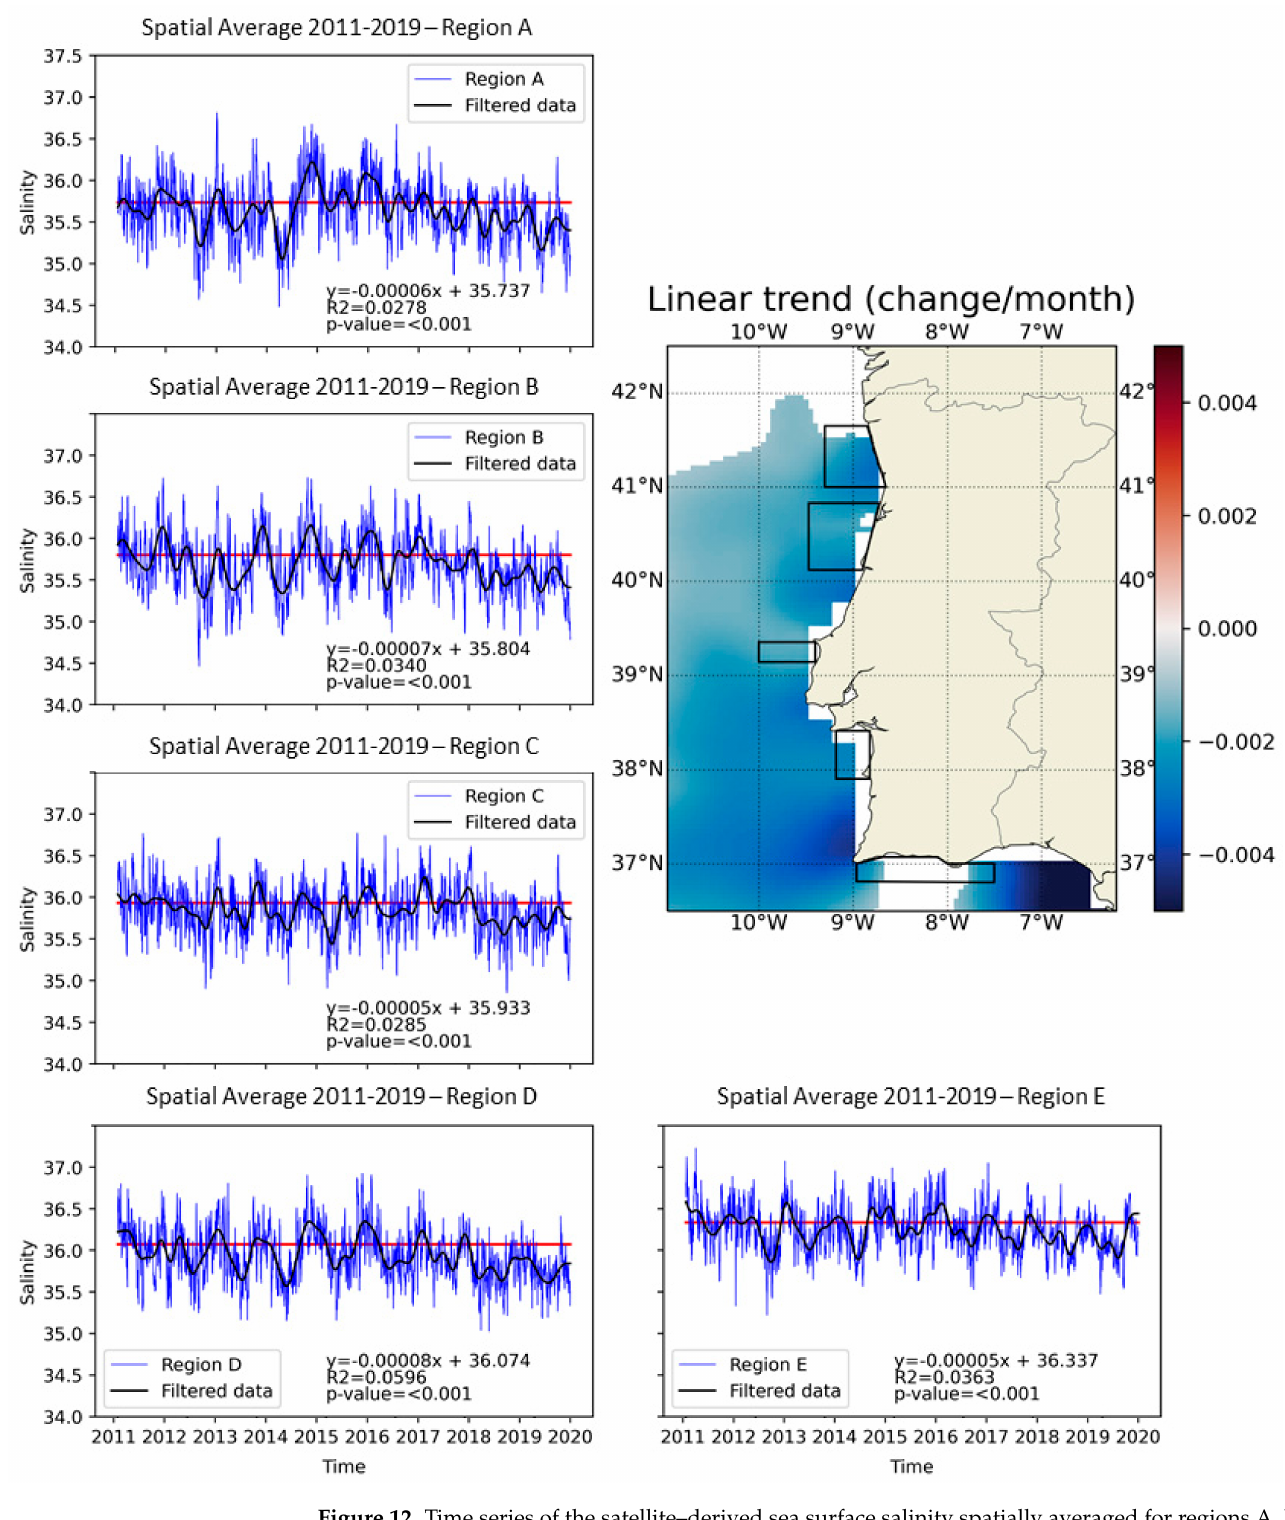
Figure 12. Time series of the satellite–derived sea surface salinity spatially averaged for regions A, B, C, D, and E. Regression line represented in red along with the statistical analysis. Map of the linear trends (change per month) obtained for the Portuguese coast considering monthly time series (only significant trends, p value < 0.05, are